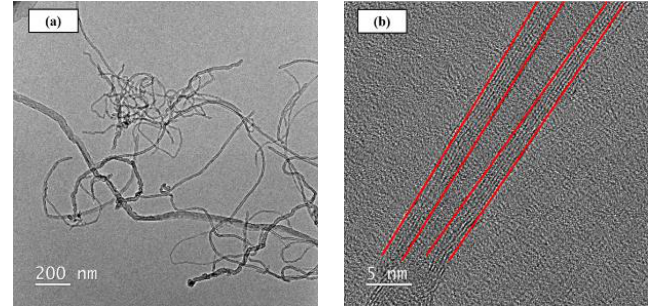
Figure 1. TEM images of as-received MWCNTs: ( a ) ×200, ( b ) ×10 k.